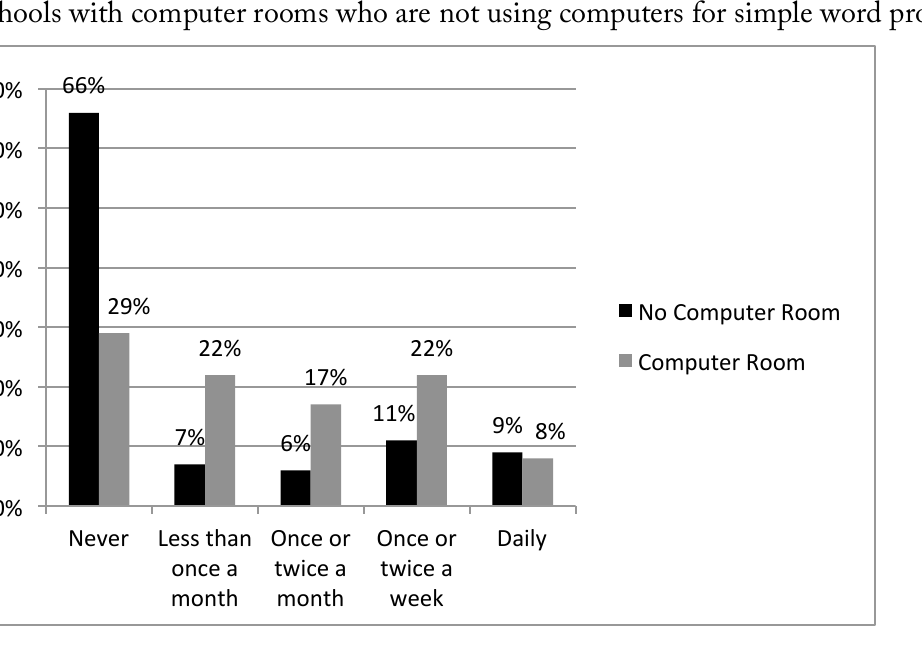
Figure 2: Educators’ computer usage in schools with or without computer